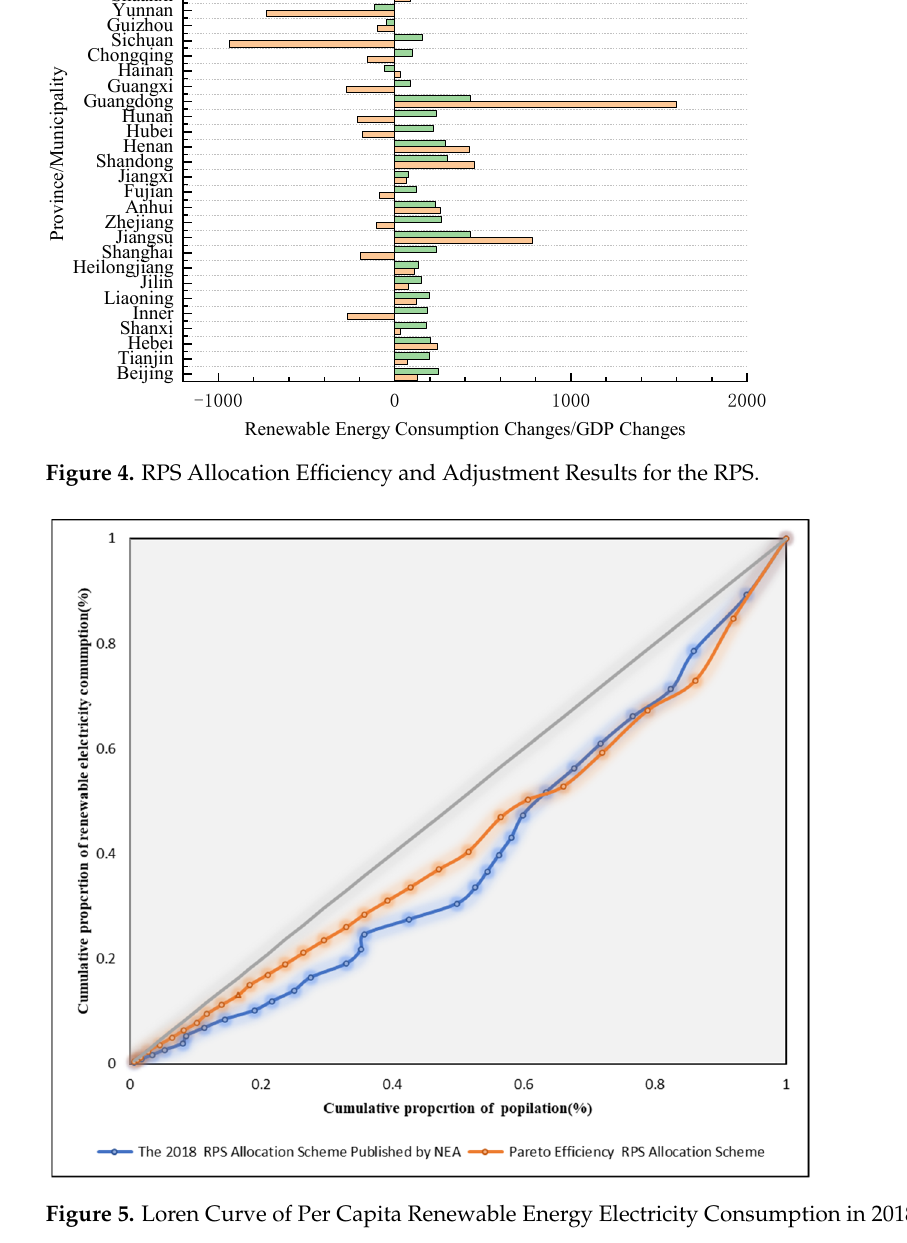
Figure 5. Loren Curve of Per Capita Renewable Energy Electricity Consumption in 2018.